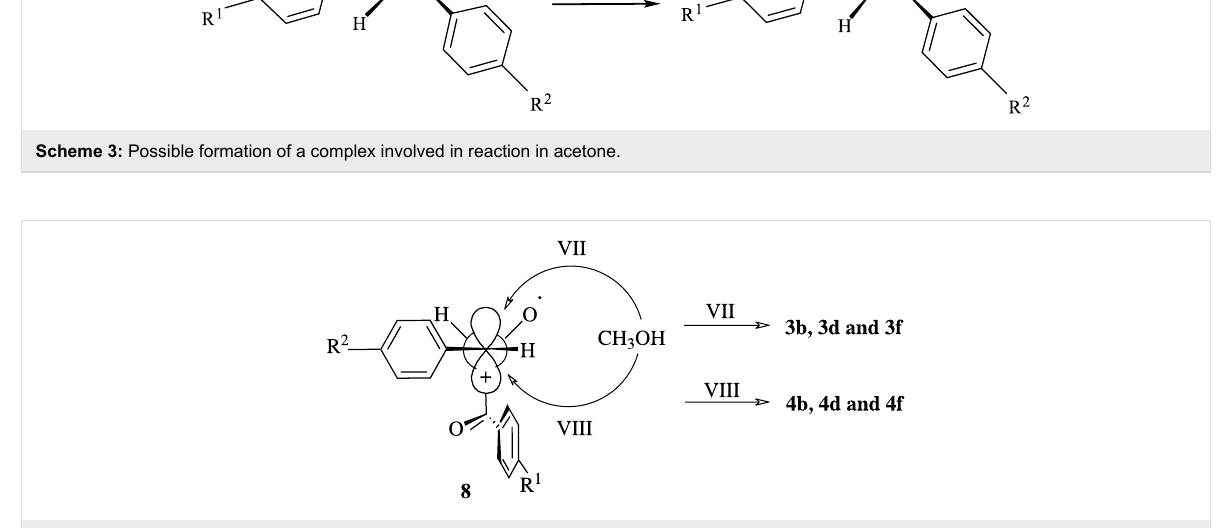
Scheme 4: Interaction of oxygen lone pair of carbonyl group with carbocation center.